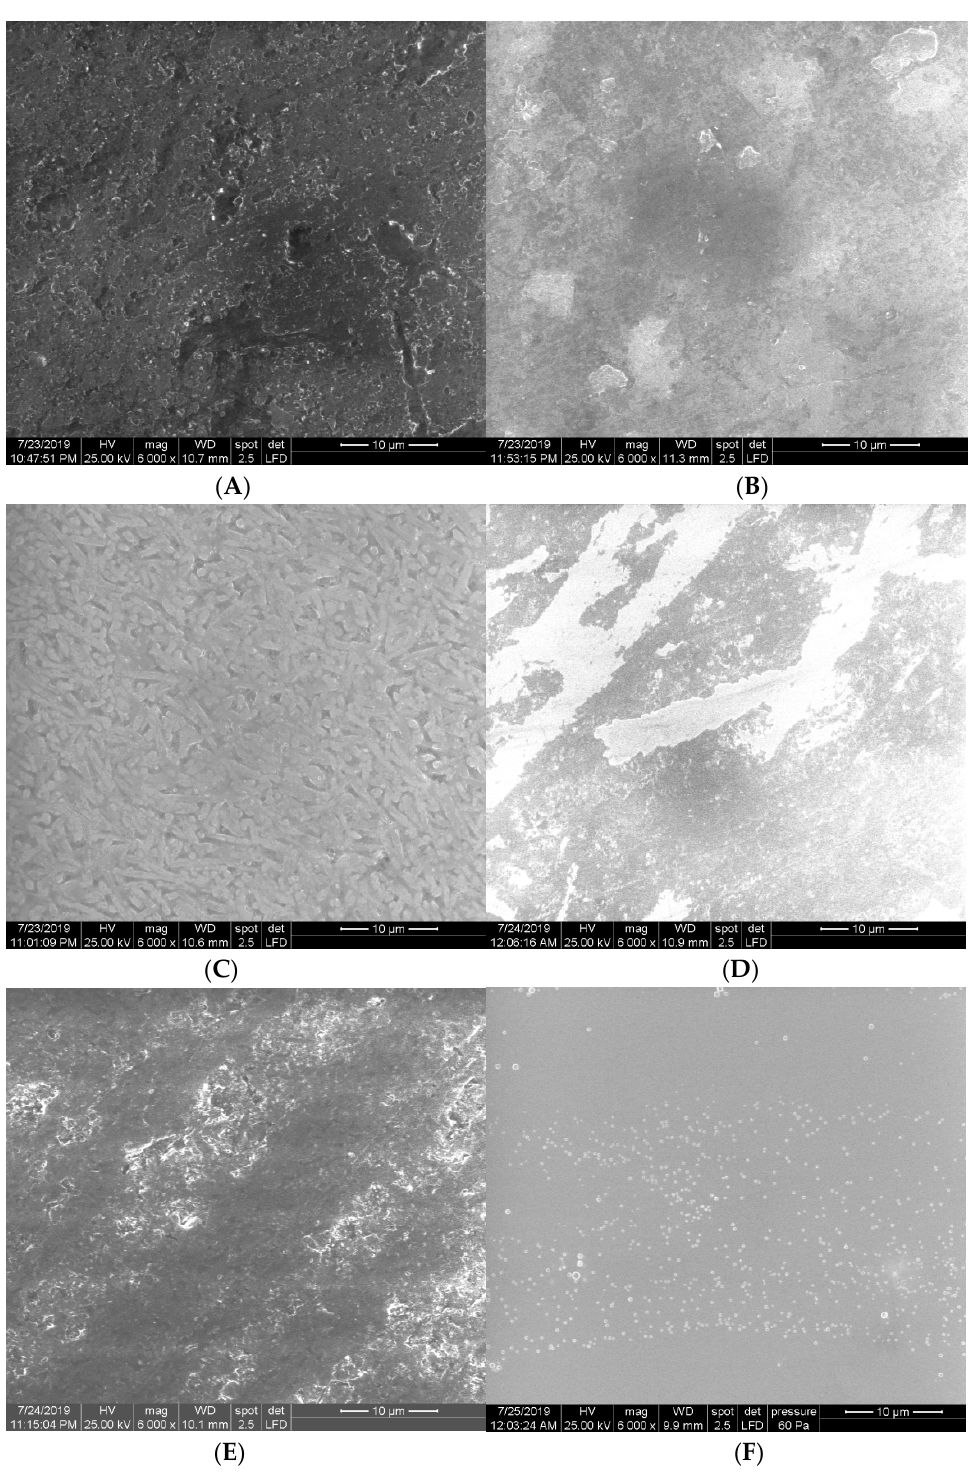
Figure 6. SEM micrographs after thermocycling. ( A ) Vita polished; ( B ) Vita glazed; ( C ) Emax polished; ( D ) Emax glazed; ( E ) Celtra polished; and ( F ) Celtra glazed.